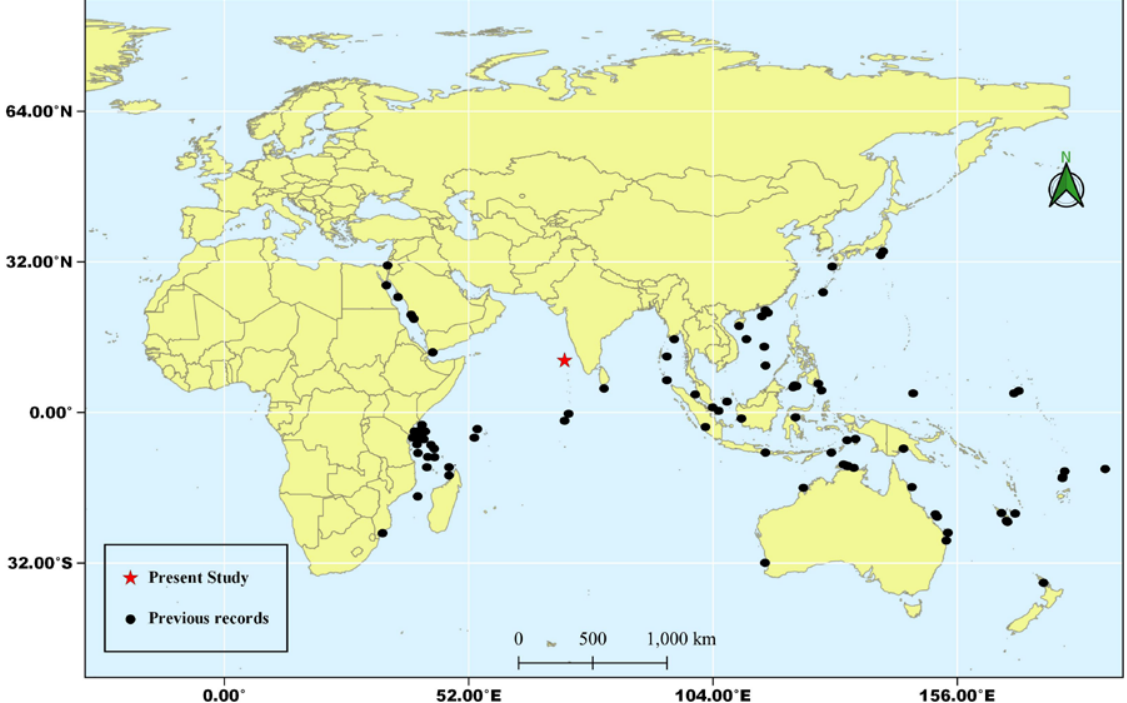
Figure 5. Biogeographical distribution of Palaemonella rotumana (Borradaile, 1898)